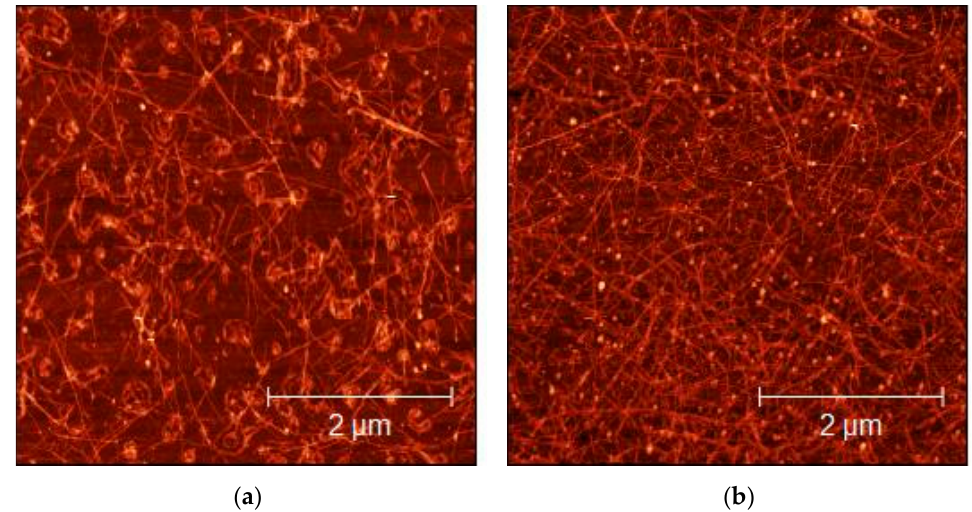
Figure 5. AFM micrograph of 1:15 diluted SDS-SWCNT-sprayed dispersions on glass substrates: ( a ) 10 layers; ( b ) 50 layers.